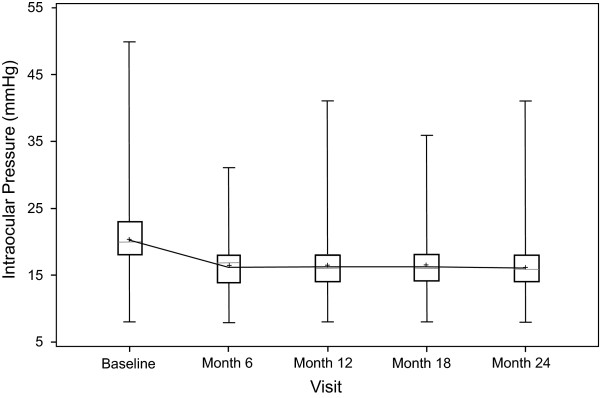
Box-plot of intraocular pressure by visit, PP population. PP = per protocol. Bars represent minimum and maximum values. Boxes represent interquartile range and median. Line presents the mean profile over time.